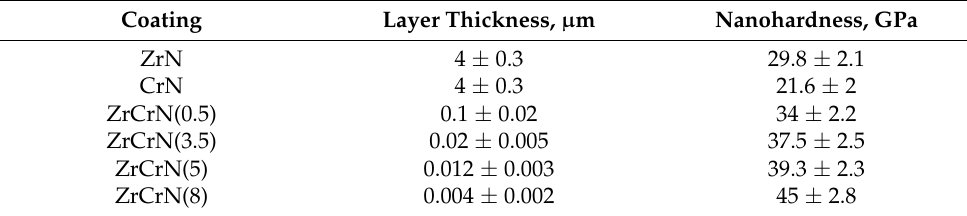
Table 1. Coatings and characteristics.